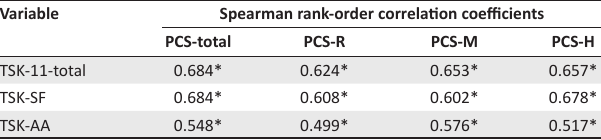
TABLE 4: Correlation between the Tampa Scale for Kinesiophobia-11 and Pain Catastrophising scales and their subscales.